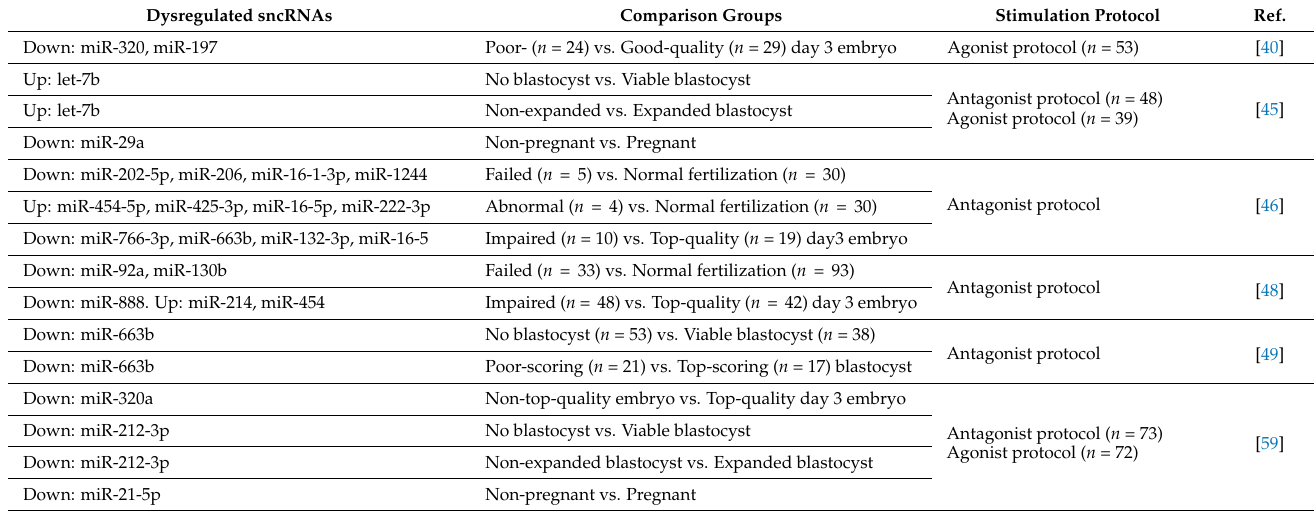
Table 2. List of differentially expressed sncRNAs in the follicular fluid after validation by qRT-PCR in the included studies. Dysregulated sncRNAs Comparison Groups Stimulation Protocol